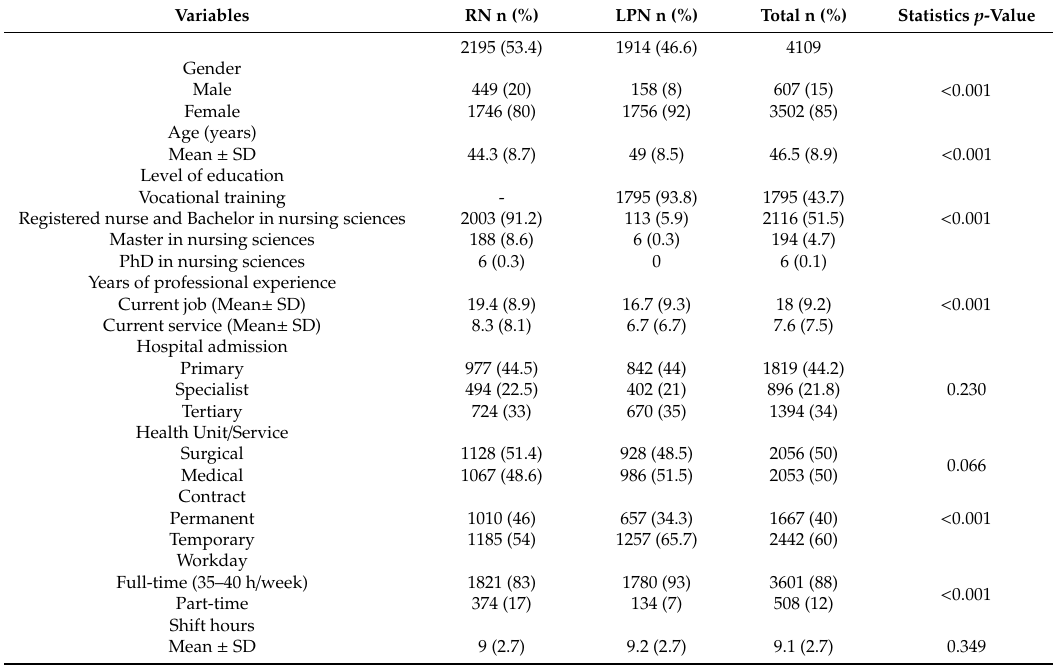
Table 1. Sample characteristics.